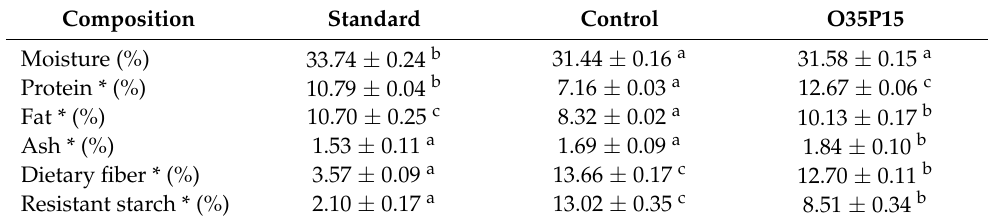
Table 7. Chemical composition of standard (100% WF), control (100% SGBF) and O35P15.